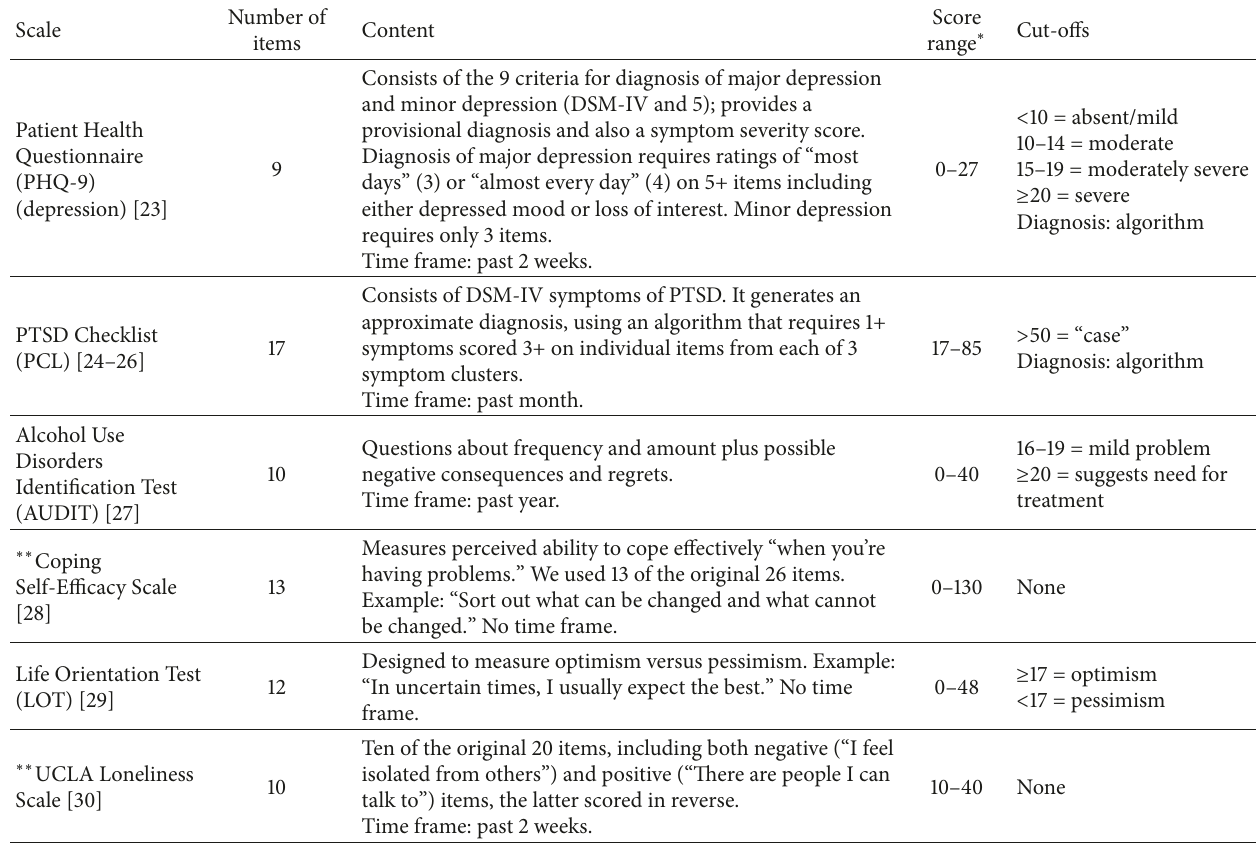
Table 1: Study measures: items, content, score range, and cut-offs (if applicable ) ∗